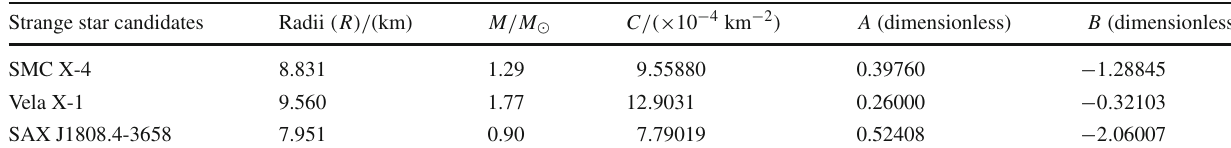
Table 1 Constant parameters calculated for radii and mass for some strange star candidates with α = 0 . 3